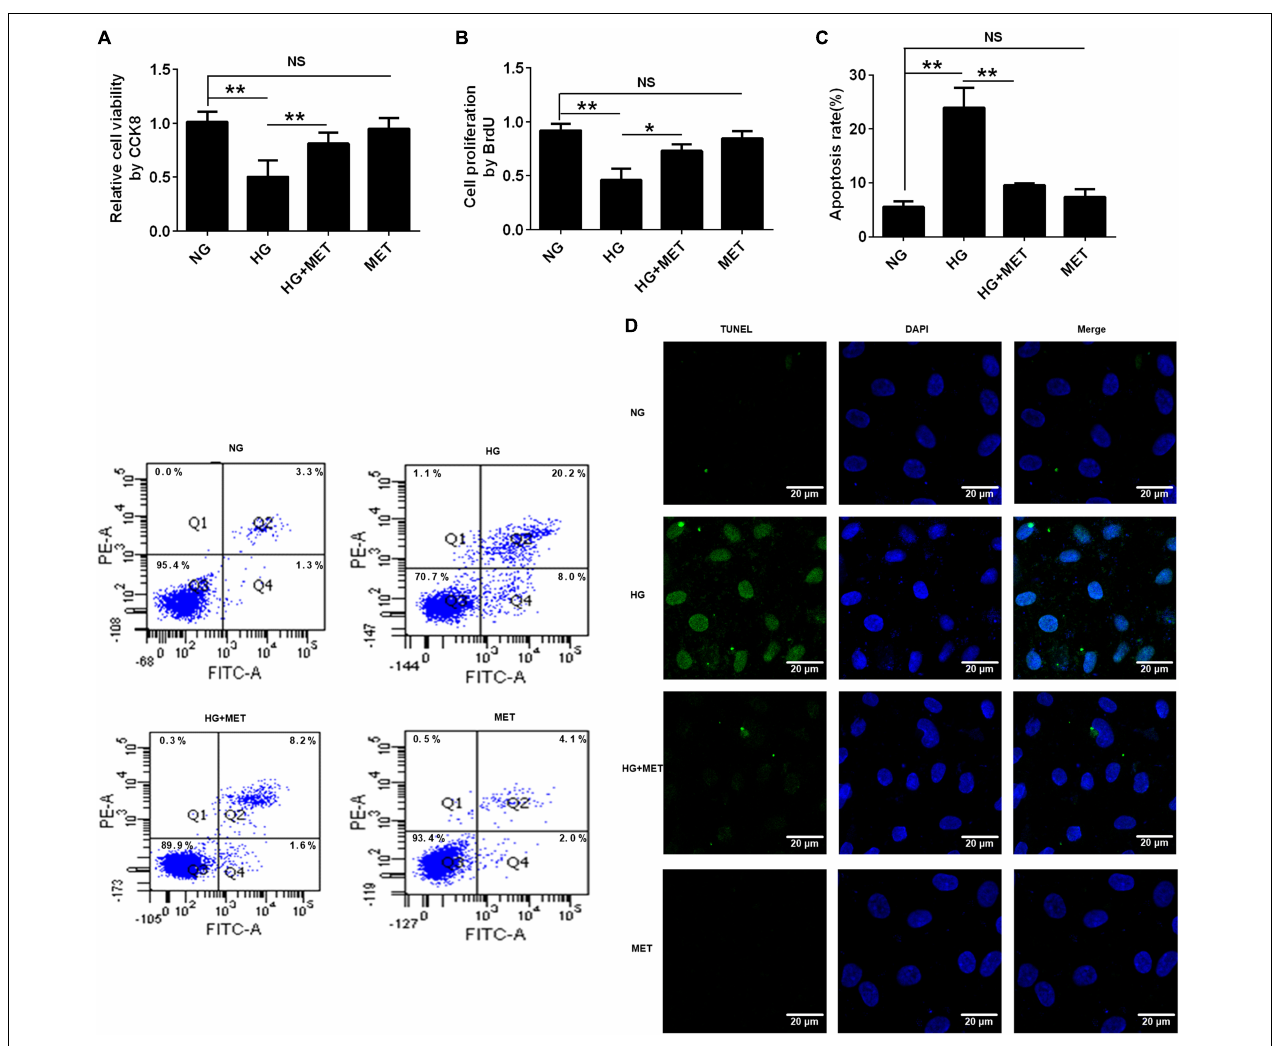
FIGURE 3 | The effects of metformin on HUVEC cell proliferation and apoptosis in response to HG treatment. (A) CCK8 assay in HUVECs treated with NG, HG (33.3 mmol/l), HG plus 0.01 mmol/l metformin (HG + MET), and MET (0.01 mmol/l) conditions. (B) BrdU incorporation assay in HUVECs treated with NG, HG, HG + MET, and MET. (C) Annexin V/PI assay in HUVECs treated with NG, HG, HG + MET, and MET. The histograms represent the apoptosis rates in the four groups. (D) Representative photographs of TUNEL staining in the different groups. The results are expressed as the means ± SD. ∗ p < 0.05, ∗∗ p < 0.01; NS, not significant; one-way